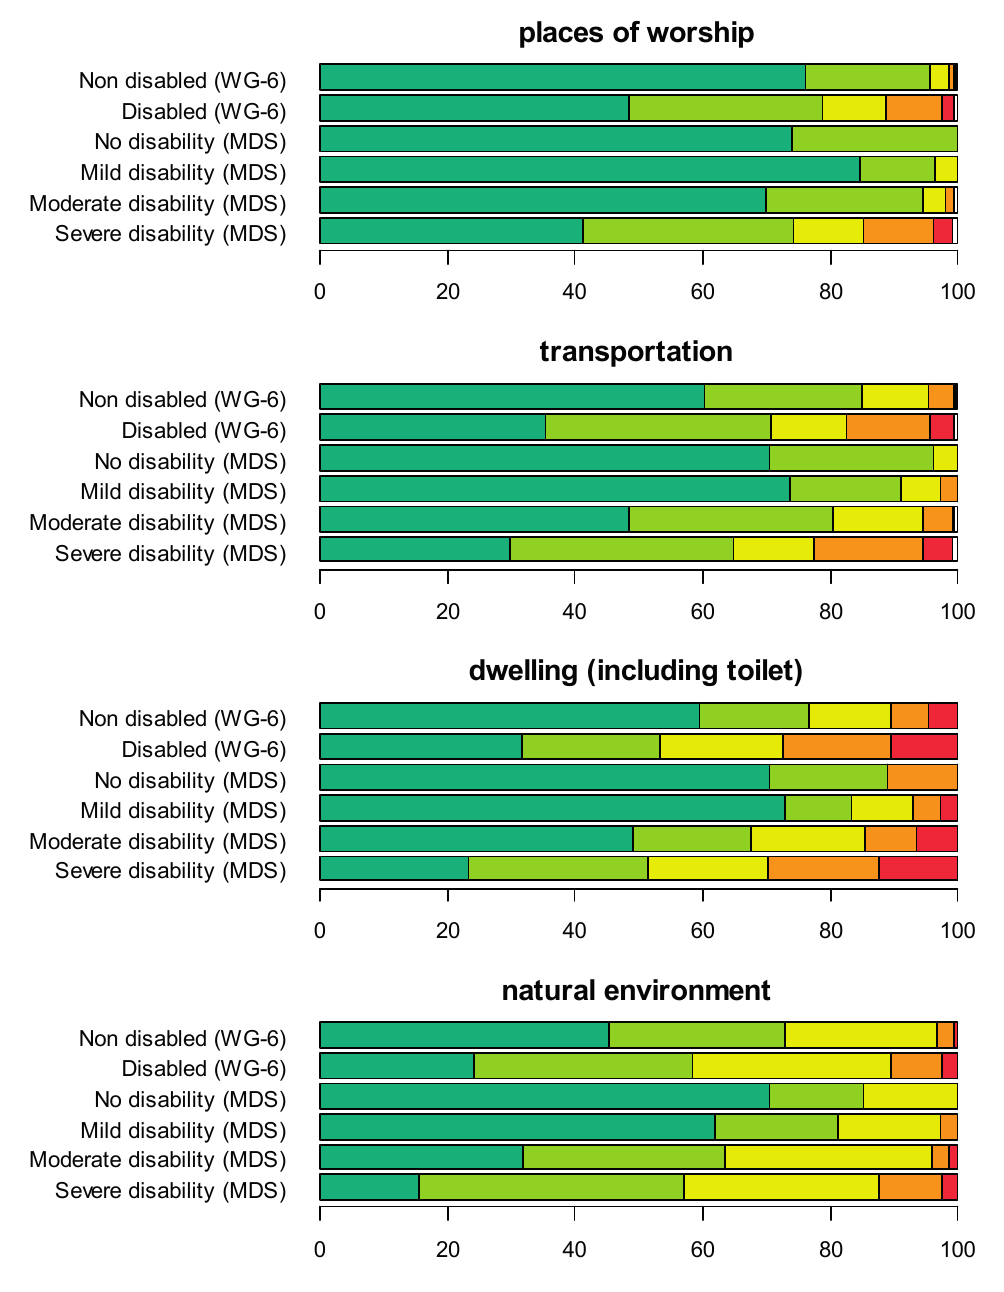
Figure 6. Comparison of the samples generated with the functioning screener approach and the WRD approach for several aspects of the environment that might be hindering and facilitating, on a scale from one to five, where one (dark green) means very easy and five means very hard (red). Dark green: very easy; light green: easy; yellow: neither easy nor hard; orange: hard; red: very